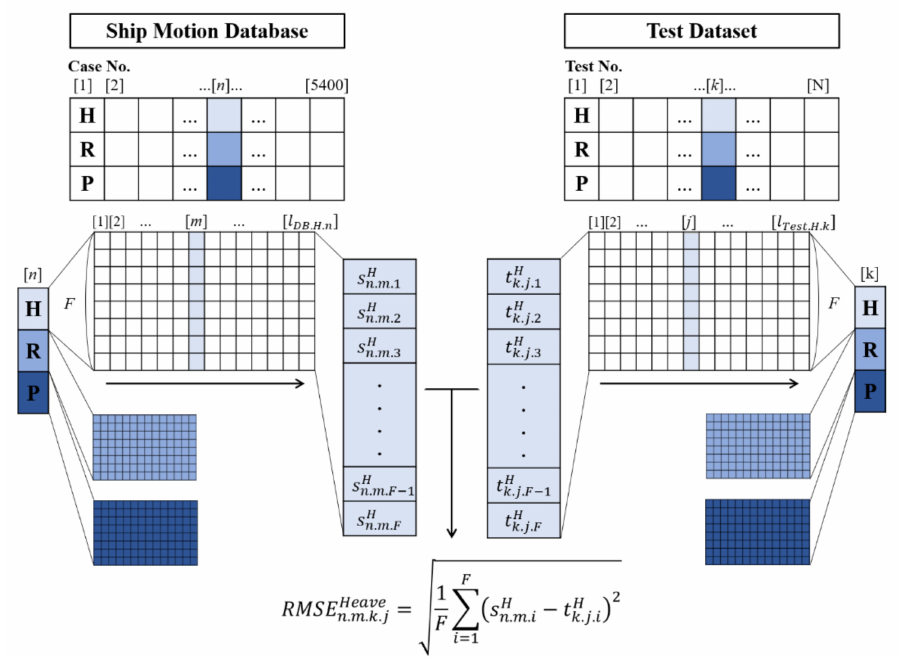
Figure 13. Procedure of the RMSE calculation between the motion database and the test